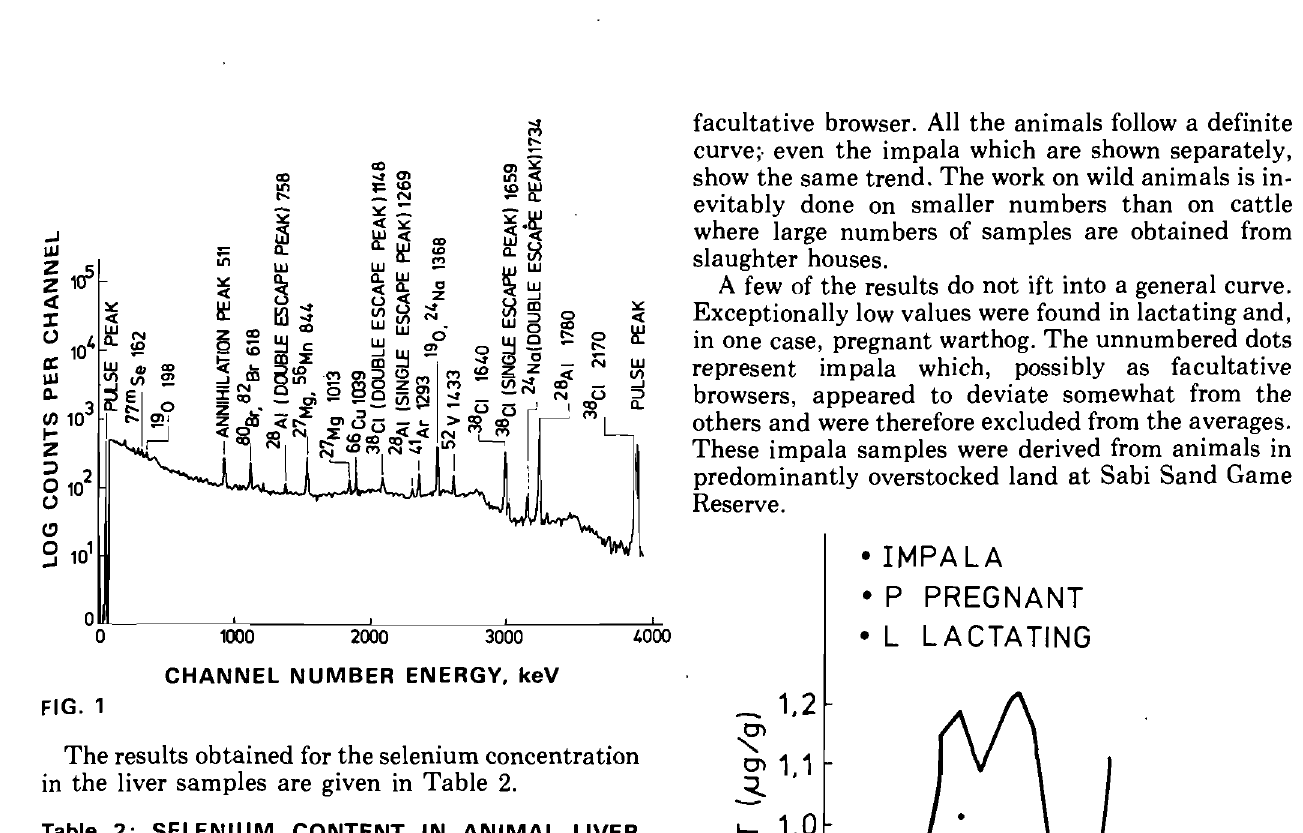
FIG. 1 The results obtained for the selenium concentration in the liver samples are given in Table 2. Table 2: SELENIUM CONTENT IN ANIMAL LIVER DETERMINED BY NEUTRON ACTIVATION